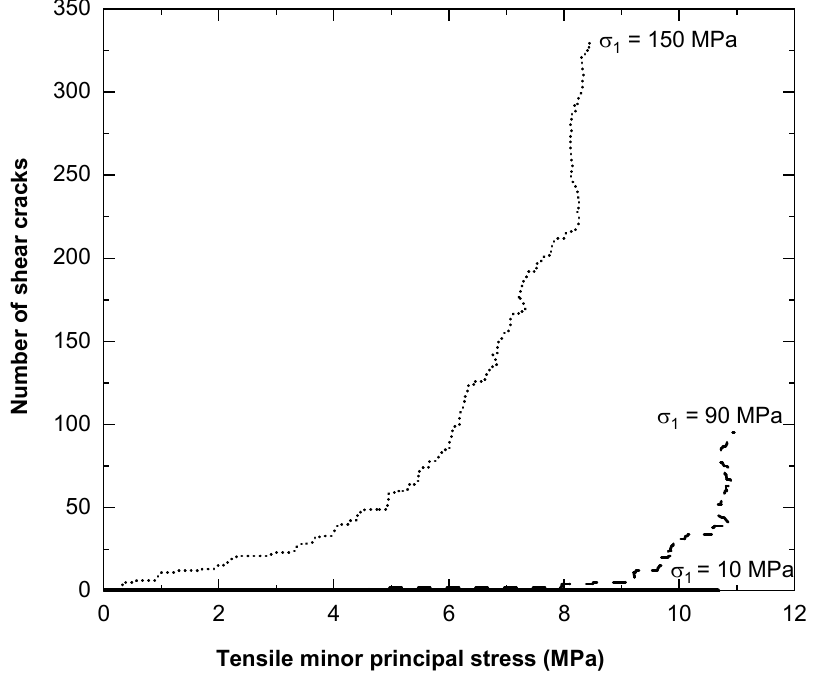
Figure 14. Number of shear cracks formed with an increase in σ 3 for numerical confined extension tests at low (10 MPa), medium (90 MPa), and high (150 MPa) confinements (from point E to point C; Figure 8).